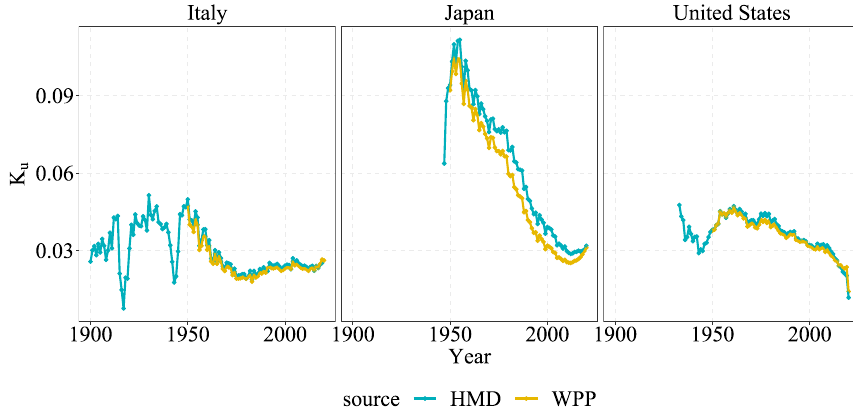
Fig. 6 K u value in 3 countries from HMD and WPP, 1900–2020